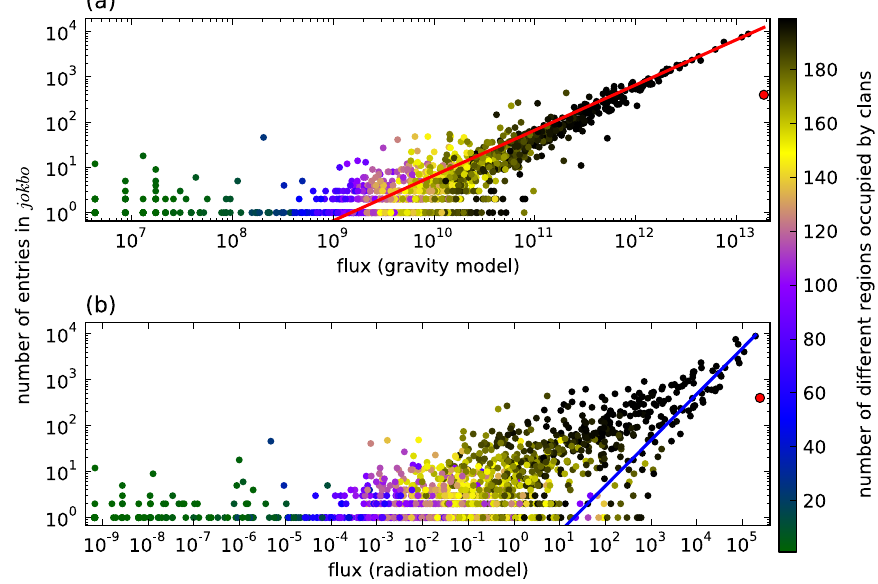
FIG. 2. Flux predictions from the population-product model (i.e., the special case of the gravity model with γ ¼ 0 ) with α ¼ 1 and the radiation models for jokbo 1. (a) Scatter plot of the number of clan entries in jokbo 1 versus the corresponding centroid in 2000 using the ≈ 6 . 55 ð 4 Þ × population-product-model flux with α ¼ 1 . We compute the line using a linear regression to find the fitting parameter a G 10 − 11 (with a 95% confidence interval) to satisfy the expression N a G , where G is the population-product-model flux of women i ¼ G ij ij from clan i to clan j and N is the total number of entries from clan i in the jokbo . (b) We compare the same clan entries using the i ≈ 0 . 049 ð 2 Þ to satisfy the expression radiation model. We compute the line using a linear regression to find the fitting parameter a R N a R , where R is the radiation-model flux of women from clan i to clan j and N is the total number of entries from clan i in the i ¼ R ij ij i jokbo . In both panels, we color the points using the number of administrative regions that are occupied by the corresponding clans [see Figs. 3(a) and (b)]. The red markers (outliers) in both panels correspond to the clan of jokbo 1 (i.e., the case i ¼ j